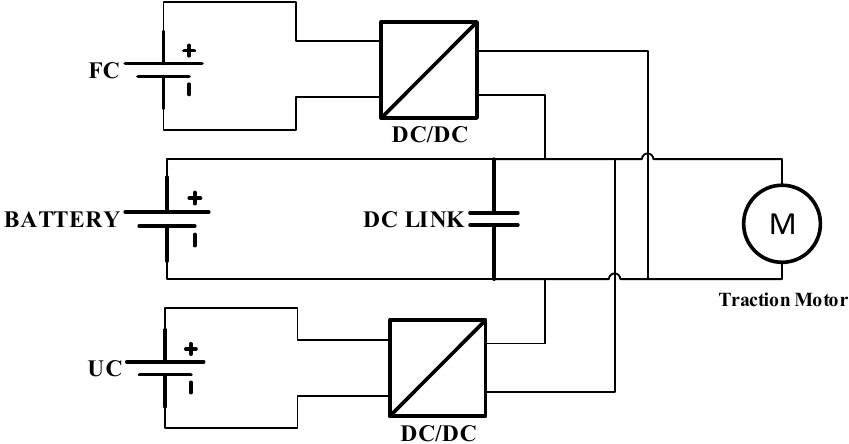
Figure 1. Fuel cell (FC) hybrid propulsion system configuration. Battery, FC, and UC are power sources of this hybrid system.